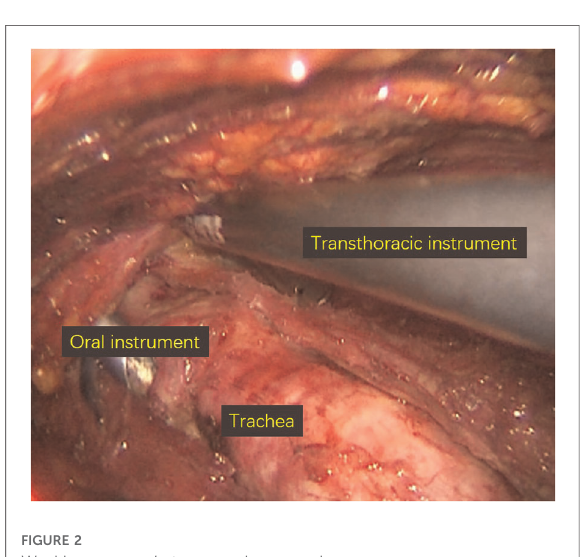
FIGURE 2 Working space via trans-oral